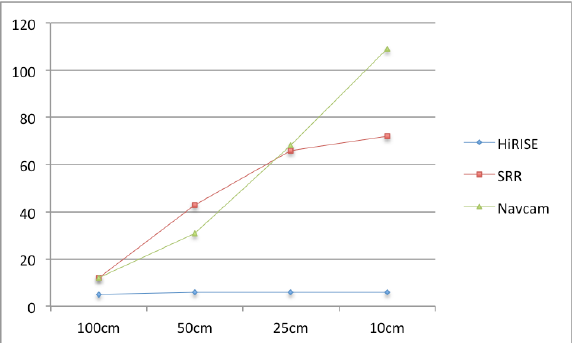
Figure 18 Rock frequency-size distribution for HiRISE, SRR and Navcam at MSL Sol